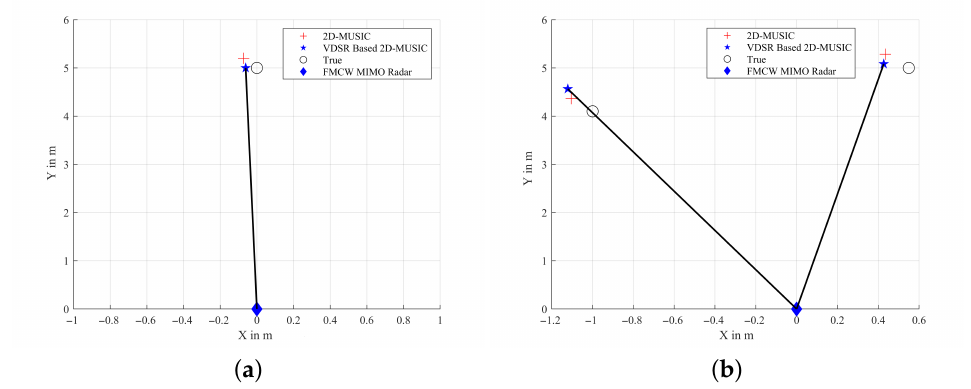
Figure 20. A comparison of target localization results: ( a ) Single target. ( b ) Two